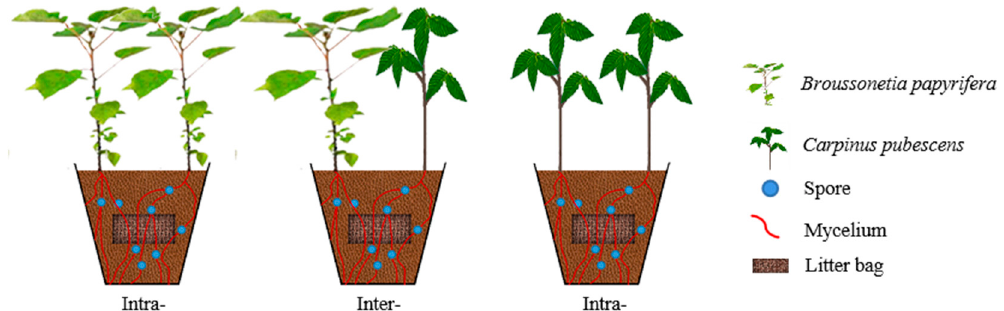
Figure 1. Diagram of the experimental design. The woody plant of Broussonetia papyrifera and Carpinus pubescens seedlings were inoculated by AM fungus of Claroideoglomus etunicatum . The litter bags = a 10 g of litter mixture of B. papyrifera and C. pubescens . Intra- = intraspecific competition of B. papyrifera or C. pubescens ; Inter- = interspecific competition of B. papyrifera and C. pubescens